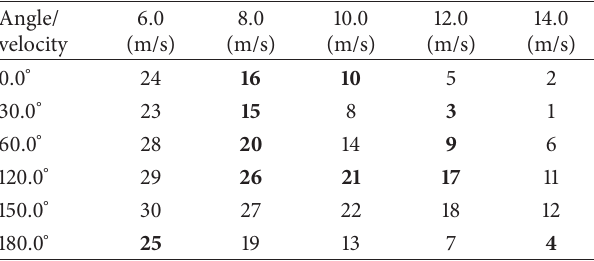
Table 6: Wind load ranking magnitude for panels with holes. Number 1 indicates the highest possible wind force and number 30 the smallest one. Bold font values indicate that the wind force ranking has been affected in comparison to panels with holes. Angle/